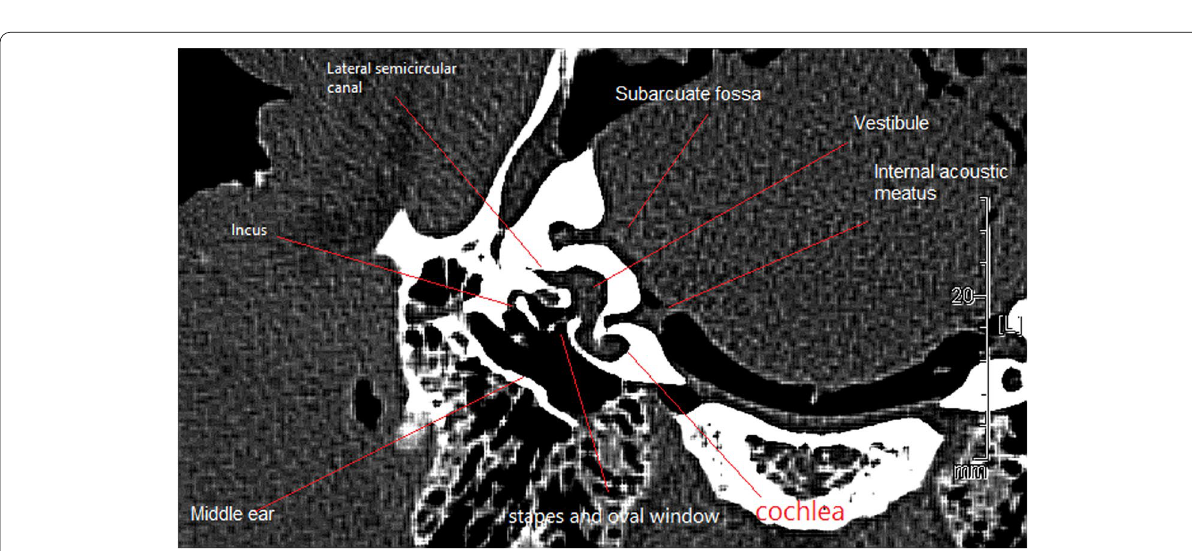
Fig. 4 Transverse computed tomography image of the camel temporal bone at the level of the left lateral semicircular